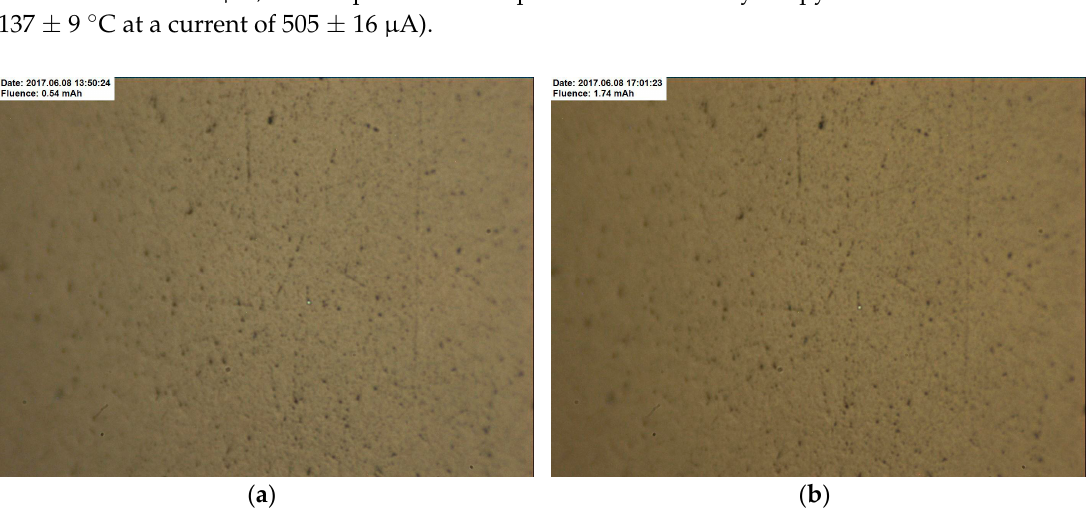
Figure 22. Images of the surface of Sample 5 during irradiation by a 2-MeV proton beam with varying integrals of the current: ( a ) 0.54, ( b ) 1.74 mA·h. The frame size is 9 mm horizontally and 4 mm integrals of the current: ( a ) 0.54, ( b ) 1.74 mA · h. The frame size is 9 mm horizontally and 4 mm vertically.